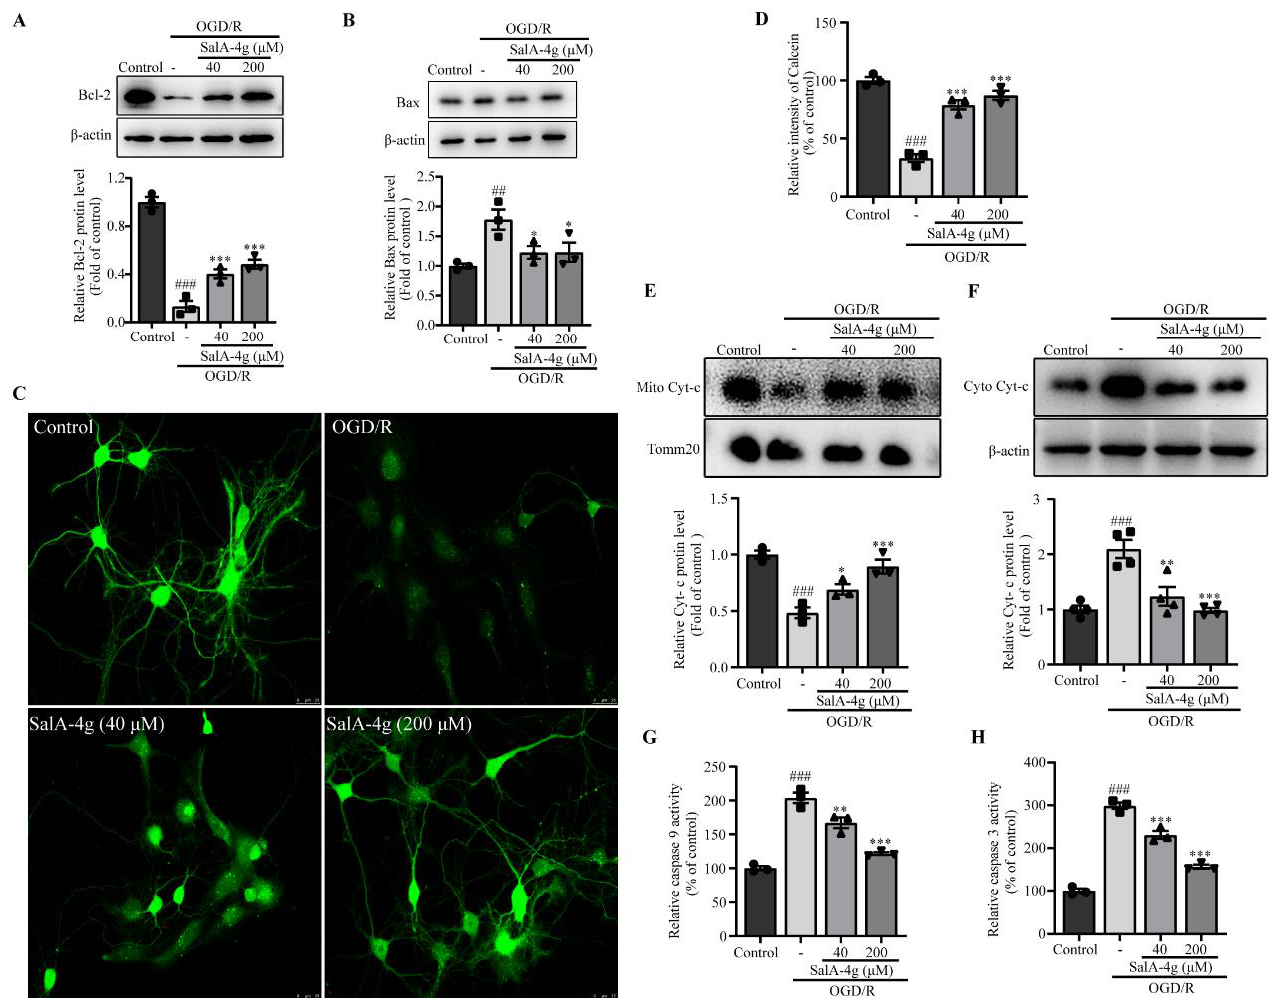
Figure 5. SalA-4g inhibits mitochondrial apoptosis pathway in cortical neurons under OGD/R stress. ( A , B ) Western blot analysis of Bcl-2 ( A ) and Bax ( B ) expression of control cells, cells exposed to 2.5 h of OGD and 24 h of reoxygenation alone, and cells treated with different concentrations of SalA-4g during OGD/R period. ( C , D ) Representative fluorescence images ( C ) and quantification of average fluorescence intensity ( D ) of calcein in different groups. Scale bar, 25 μm. ( E , F ) Western blot analysis of cytochrome c expression in mitochondria ( E ) and cytosol ( F ) in different groups. ( G , H ) Histogram depicting the activation of caspase 9 ( G ) and caspase 3 ( H ) in different groups. All values are presented as mean ± SEM ( n = 3 or 4); ## p < 0.01, ### p < 0.001 versus control; * p < 0.05, ** p < 0.01, *** p < 0.001 versus OGD/R alone.